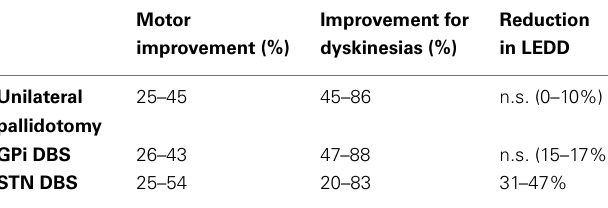
Table 2 | Effects of unilateral pallidotomy, bilateral GPi and STN deep brain stimulation (DBS) on general motor improvement (UPDRS